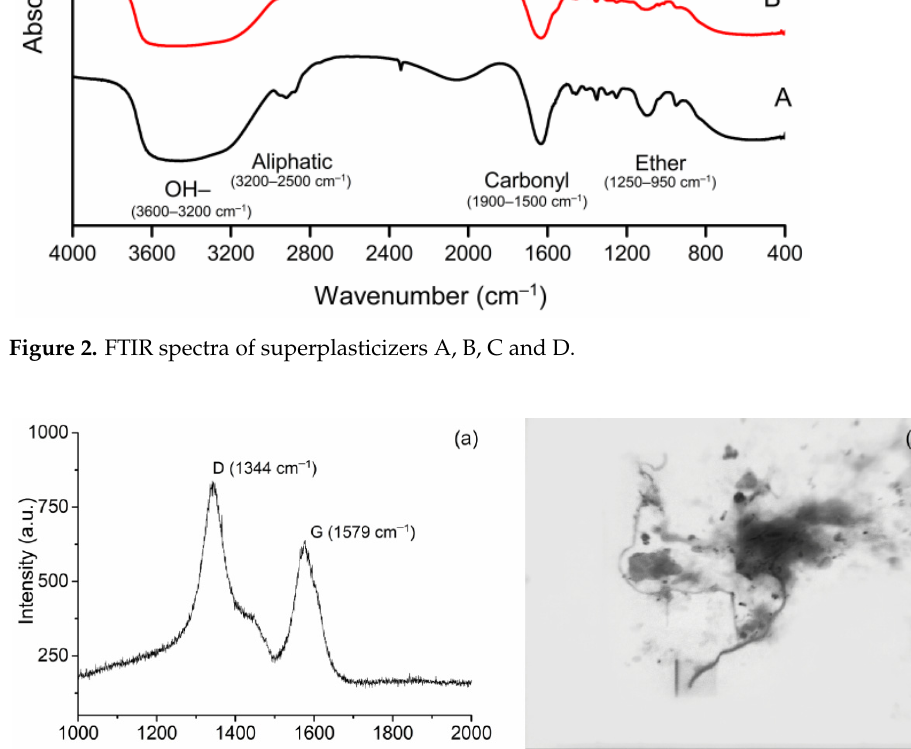
Figure 3. ( a ) RAMAN spectrum and ( b ) transmission electron microscopy of pristine CNTs.